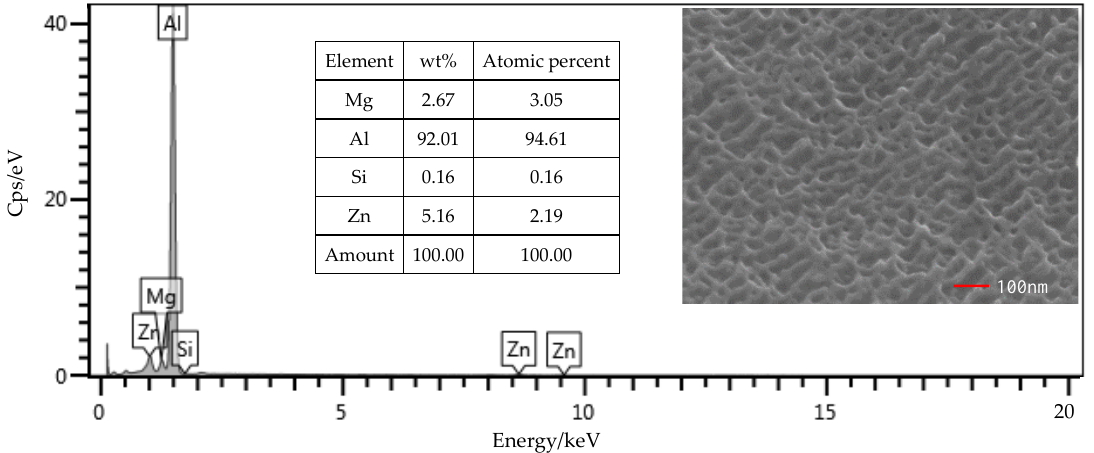
Figure 9. SEM and EDS test of the surface of the Al alloy sheet after the alkaline cleaning and acid pickling.